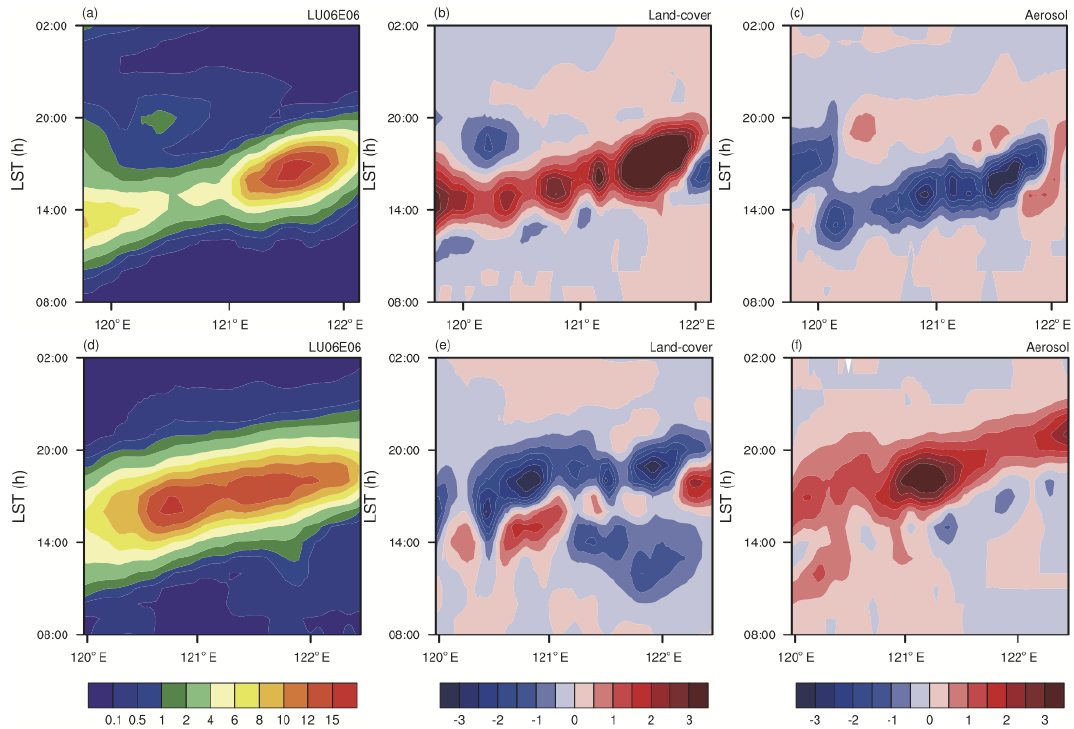
Figure 13. The time evolution of precipitation (units: mmh − 1 ) along the line ab (marked in Fig. 12a) from 08:00 on 23 June 2006 to 02:00 on 24 June 2006 (LST) (case A): (a) simulated in the LU06E06 simulation; (b) differences between LU06E70 and LU70E70; (c) differences between LU70E06 and LU70E70. Panels (d–f) are the same as (a–c) but for case B along line cd (marked in Fig. 12d) from 08:00 on 1 July 2006 to 02:00 on 2 July 2006